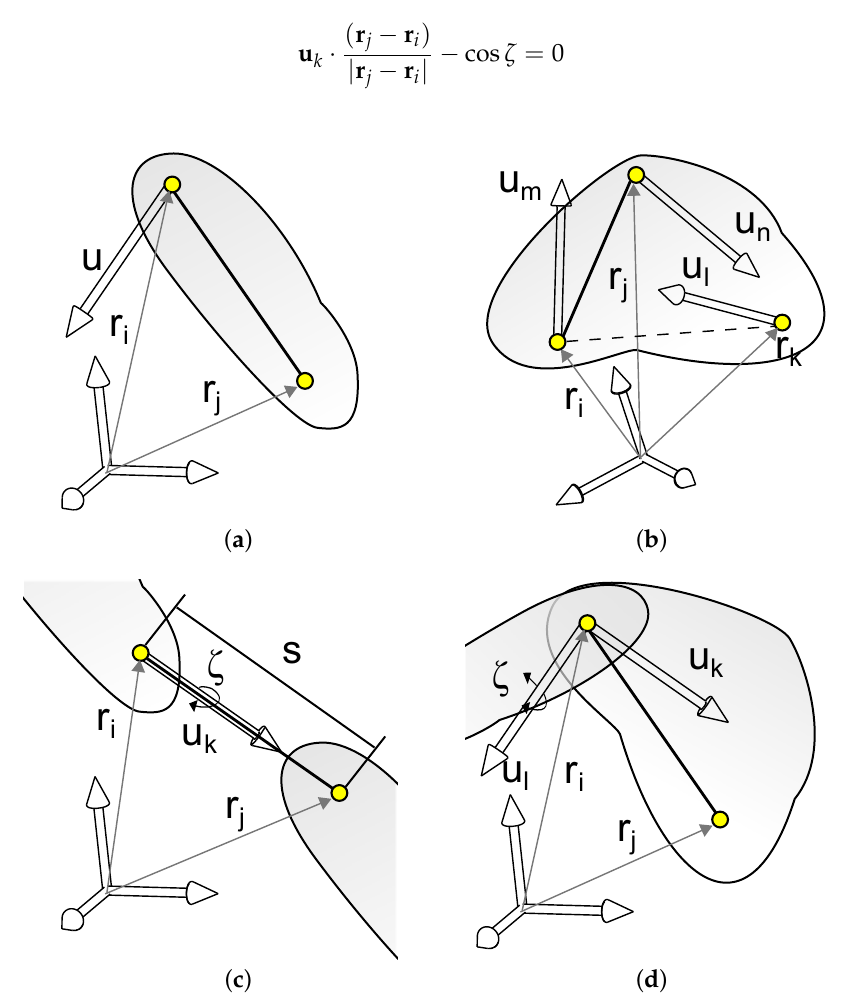
Figure 2. Modeling rigid bodies and kinematic constraints under the MBSD approach. ( a ) Two points and a unitary vector; ( b ) An algebraic basis; ( c ) Cylindrical joint; ( d ) Revolute